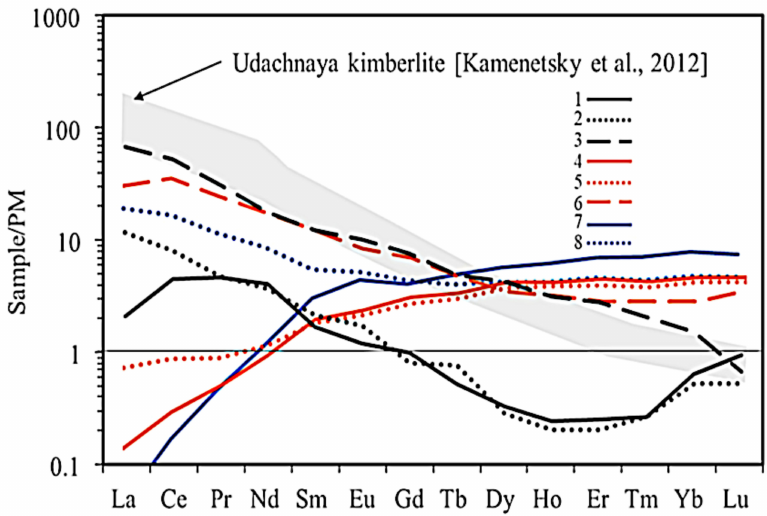
Figure 7. Primitive mantle normalized (after [45]) values of REE patterns of garnets and kelyphites from MHD, ShP, and Ecl xenoliths and REE distribution for the Udachnaya kimberlites. 1—MHD Grt (this study; average from seven samples: UV49/10, UV71/10, UV667/11, UV26/10-1,